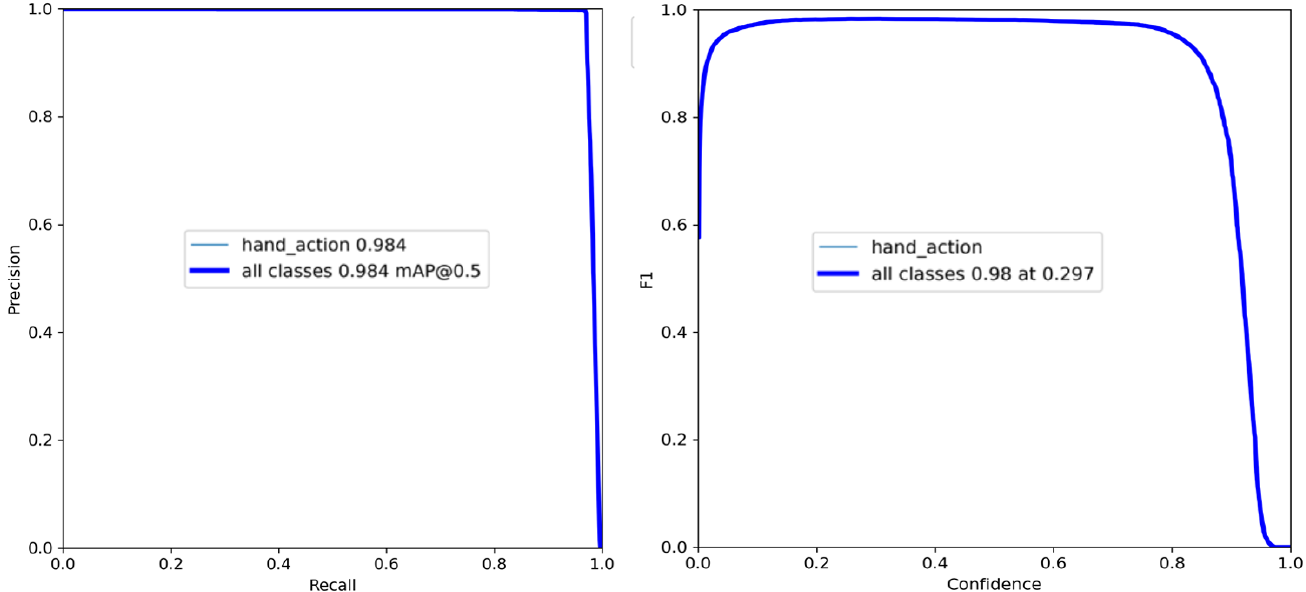
Figure 19. The distribution of precision, recall, and F1-score of hand action detection on the test set of Conf .#123 of the FPHAB dataset when Thesh IOU =